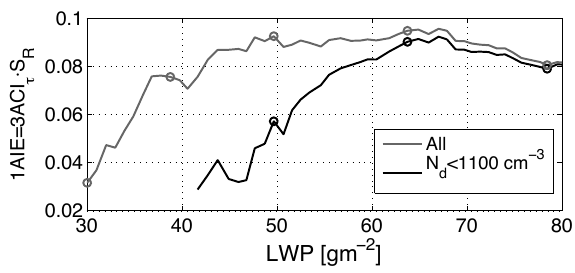
Figure 15:The first aerosol indirect effect expressed as Fig. 15. The first aerosol indirect effect expressed as 1AIE = 3 · ACI τ · S R − τ . Colors and symbols are defined in Figs. 12 and 14.